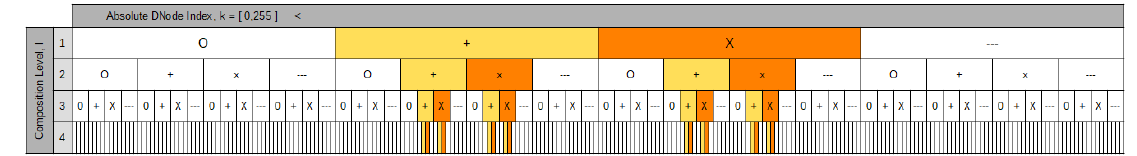
Figure 5. A DSpace in tabular format with highlighted DPaths. Table 2. A DSpace traversal using Test Set 0.